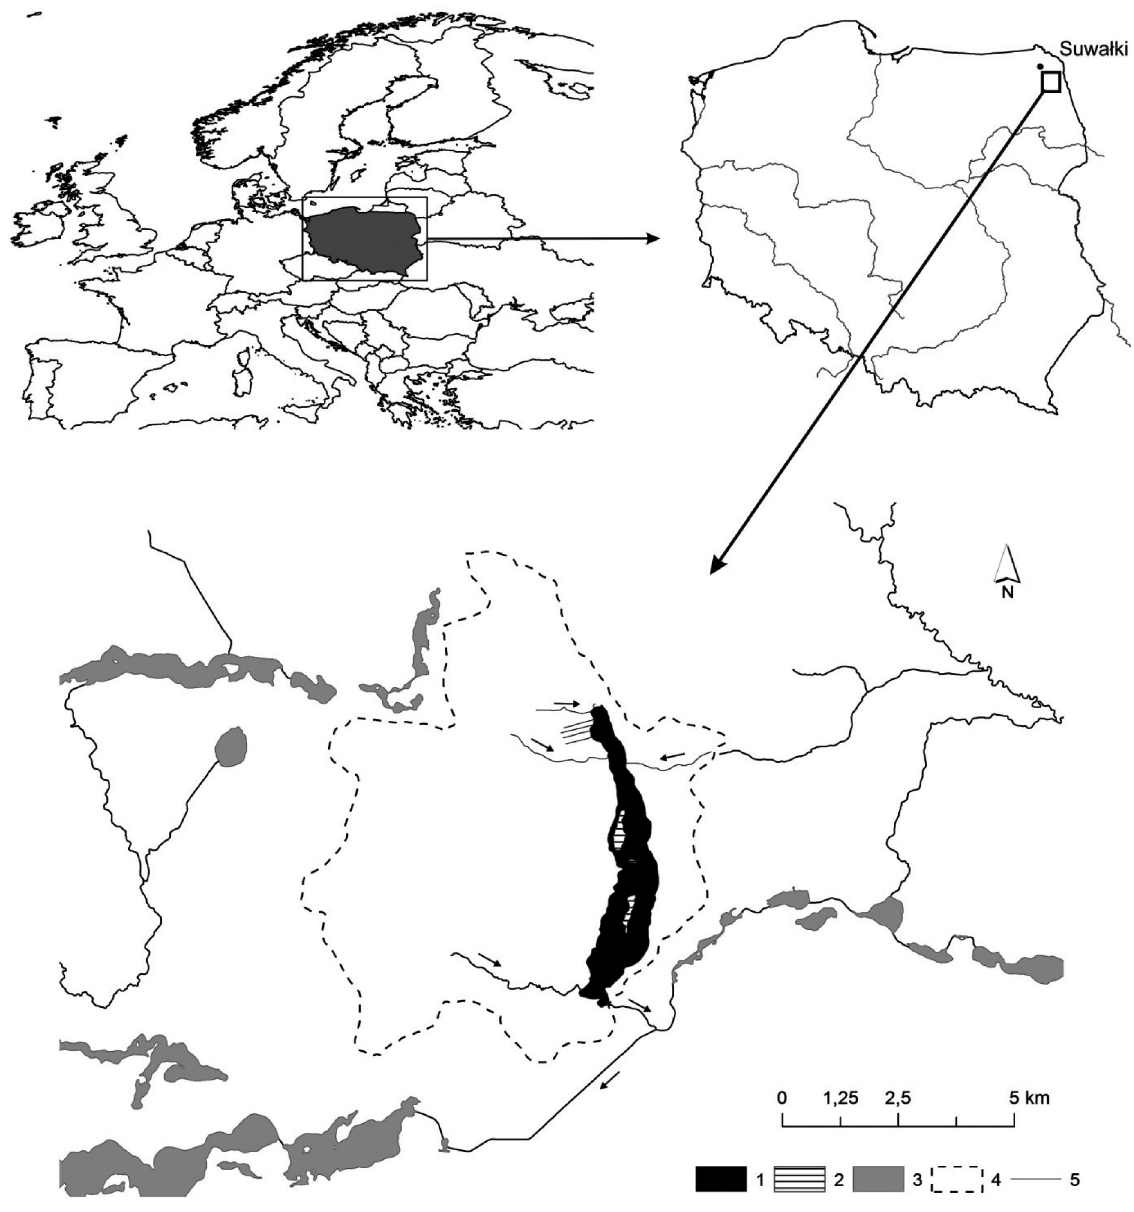
Fig. 1. Lake Serwy location from the perspective of the map of Europe and Poland. Key: 1 – Lake Serwy; 2 – islands; 3